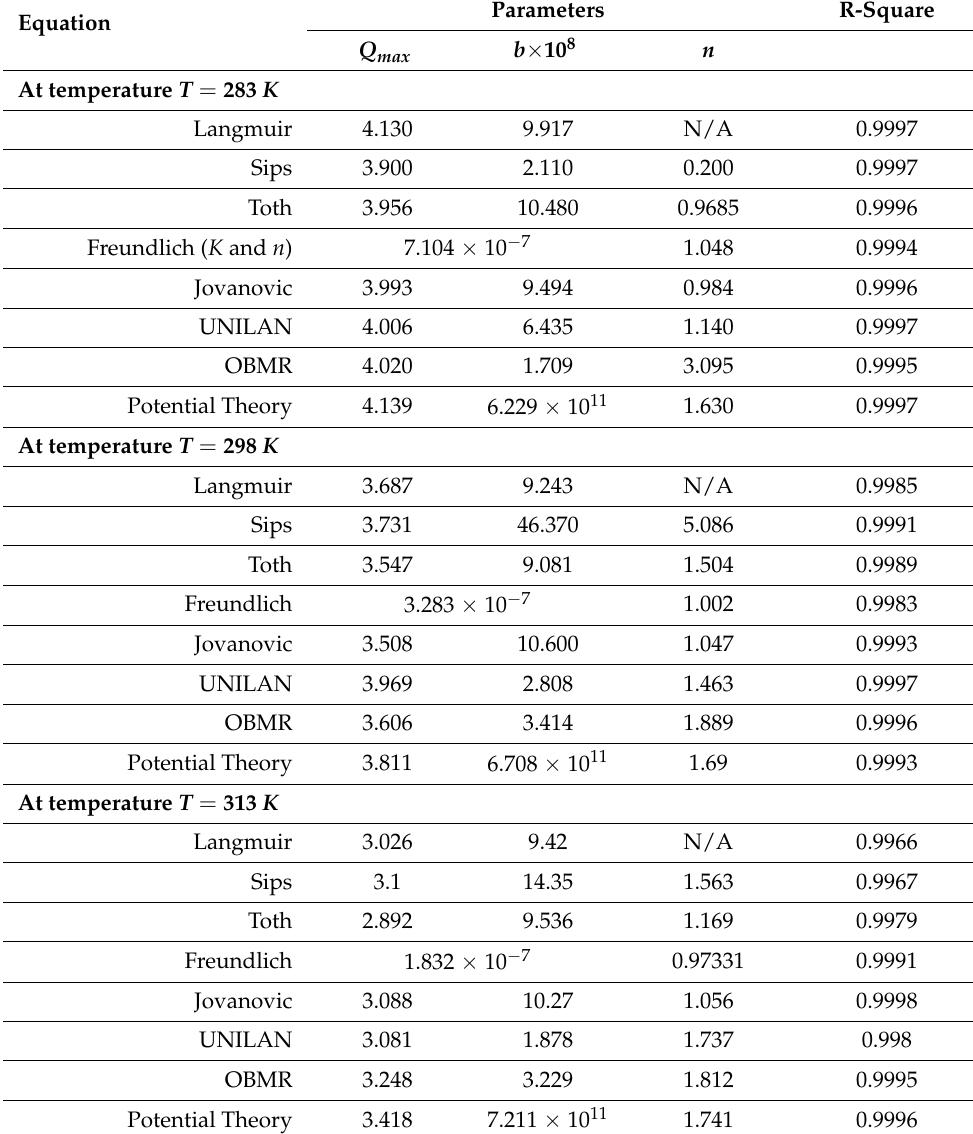
Table A1. Coefficients of the model equations obtained by nonlinear regression of experimental data for the hydrogen gas at different